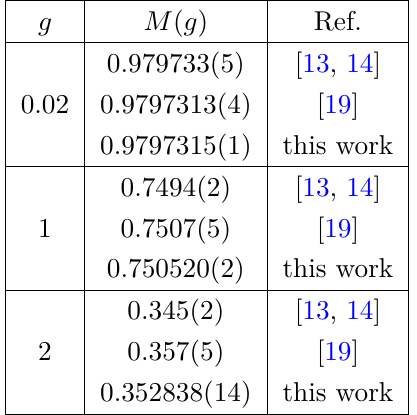
Table 1 . Comparing some OPT values for M ( g ) , in units of m , with those predicted by Hamiltonian truncations [13, 14] and Borel resummation